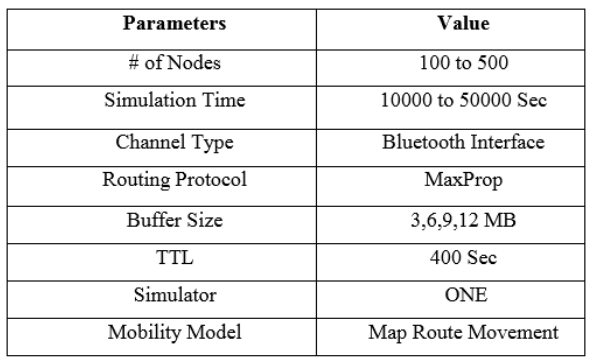
Table: 1 Simulation